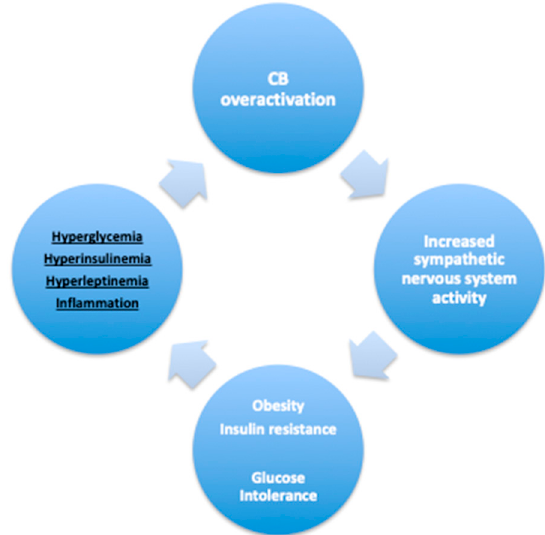
Figure 2. Mediators contributing to carotid body (CB) overactivation in metabolic diseases. Schematic representation of the several factors, such as hyperglycemia, hyperinsulinemia, hyperleptinemia, and inflammation, could induce an increase in CB that will contribute to the development of obesity, insulin resistance, and glucose tolerance through the overactivation of the sympathetic nervous system.